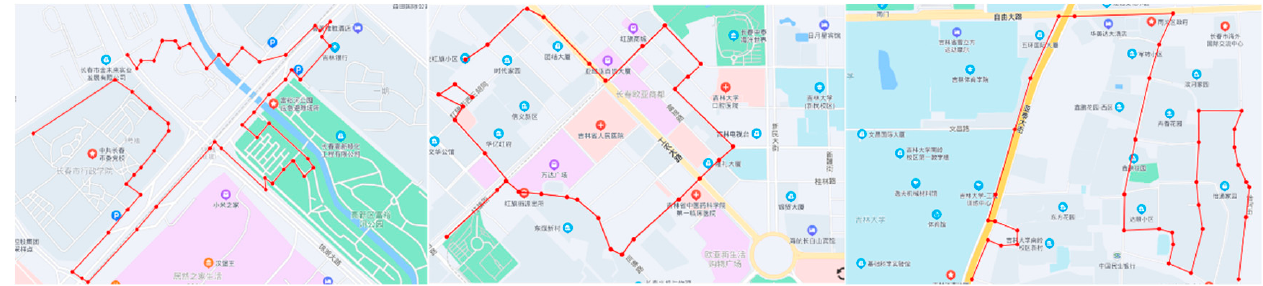
Figure 8. Roadmap of Changchun test conditions. (The red line is the actual route of the vehicle)